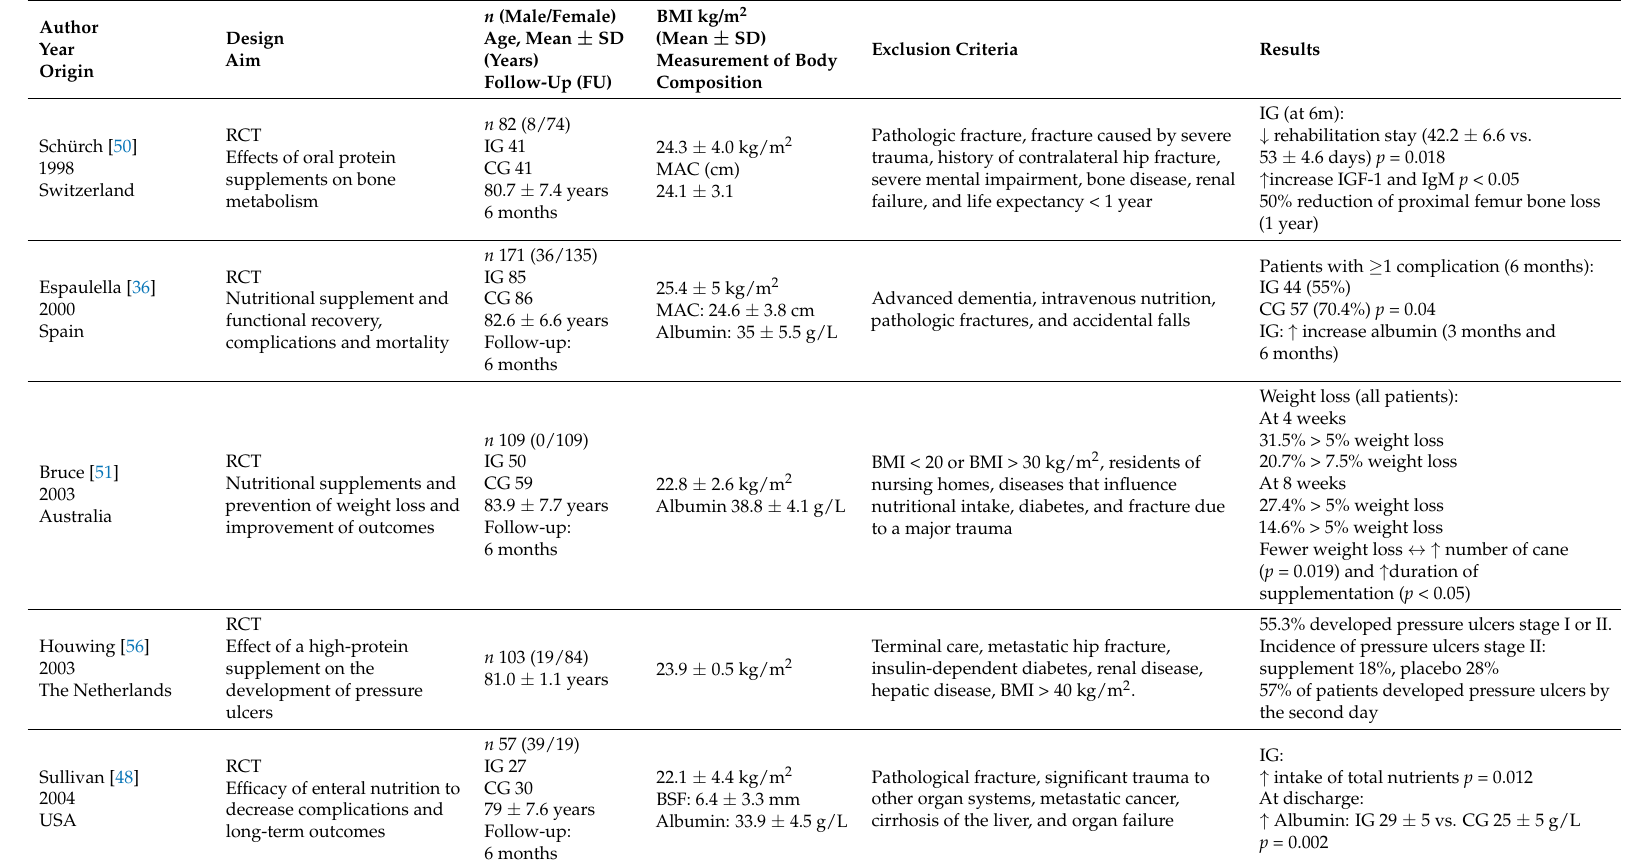
Table 6. Nutritional intervention in patients with hip